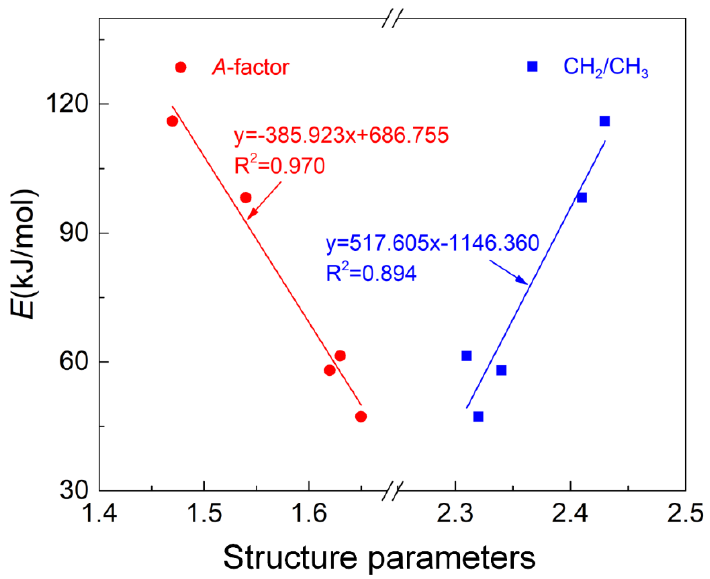
Figure 11. Relationship between activation energy and coal structure from ATR-FTIR analysis.